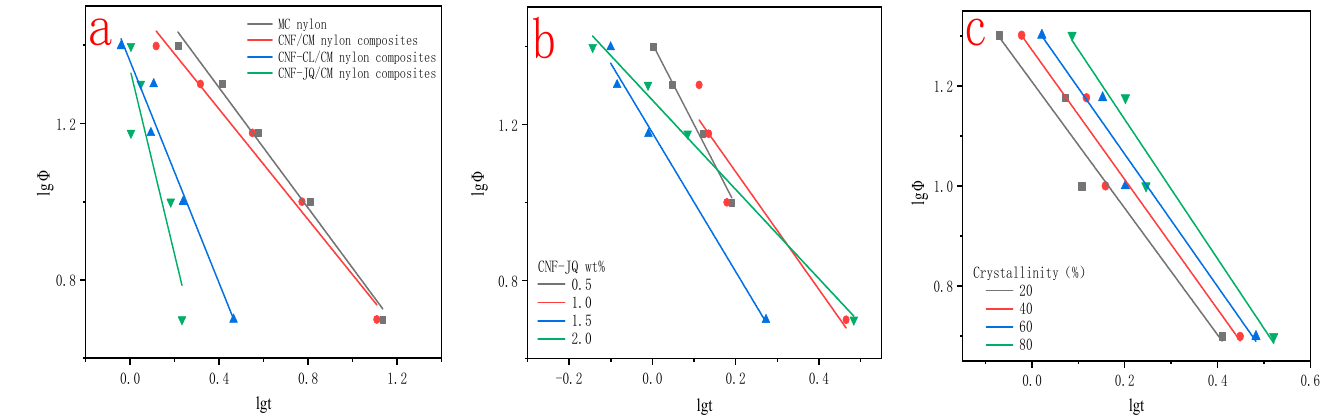
Figure 14. Curves of lgt vs. lg Φ for MC nylon and its composites (( a ) for different modified CNF; ( b ) for different CNF − JQ additions; ( c ) for different crystallinity with CNF − JQ of 1.0 wt%). Table 4. Parameters of crystallization kinetic based on Mo’s method.